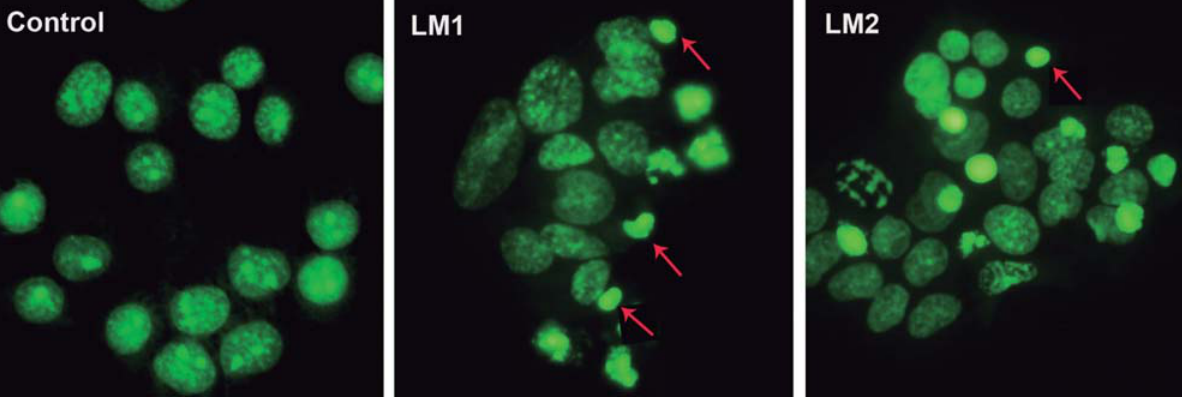
Figure 2- Morphological change of CAL 27 cells with apoptotic features. CAL-27 cells were treated with LM1 and LM2 for (cid:2)(cid:3)(cid:4)(cid:5)(cid:6)(cid:4)(cid:7)(cid:5)(cid:8)(cid:4)(cid:9)(cid:8)(cid:10)(cid:10)(cid:11)(cid:4)(cid:12)(cid:8)(cid:13)(cid:8)(cid:4)(cid:11)(cid:14)(cid:15)(cid:16)(cid:17)(cid:8)(cid:18)(cid:4)(cid:19)(cid:20)(cid:4)(cid:21)(cid:22)(cid:4)(cid:15)(cid:17)(cid:18)(cid:4)(cid:14)(cid:5)(cid:8)(cid:17)(cid:4)(cid:23)(cid:5)(cid:22)(cid:14)(cid:22)(cid:24)(cid:13)(cid:15)(cid:23)(cid:5)(cid:8)(cid:18)(cid:4)(cid:25)(cid:11)(cid:16)(cid:17)(cid:24)(cid:4)(cid:15)(cid:4)(cid:26)(cid:25)(cid:22)(cid:13)(cid:8)(cid:11)(cid:9)(cid:8)(cid:17)(cid:14)(cid:4)(cid:27)(cid:16)(cid:9)(cid:13)(cid:22)(cid:11)(cid:9)(cid:22)(cid:23)(cid:8)(cid:4)(cid:28)(cid:29)(cid:30)(cid:31)(cid:31)!(cid:6)(cid:4)(cid:7)(cid:5)(cid:8)(cid:4)(cid:15)(cid:13)(cid:13)(cid:22)(cid:12)(cid:4)(cid:16)(cid:17)(cid:18)(cid:16)(cid:9)(cid:15)(cid:14)(cid:8)(cid:11)(cid:4) apoptotic